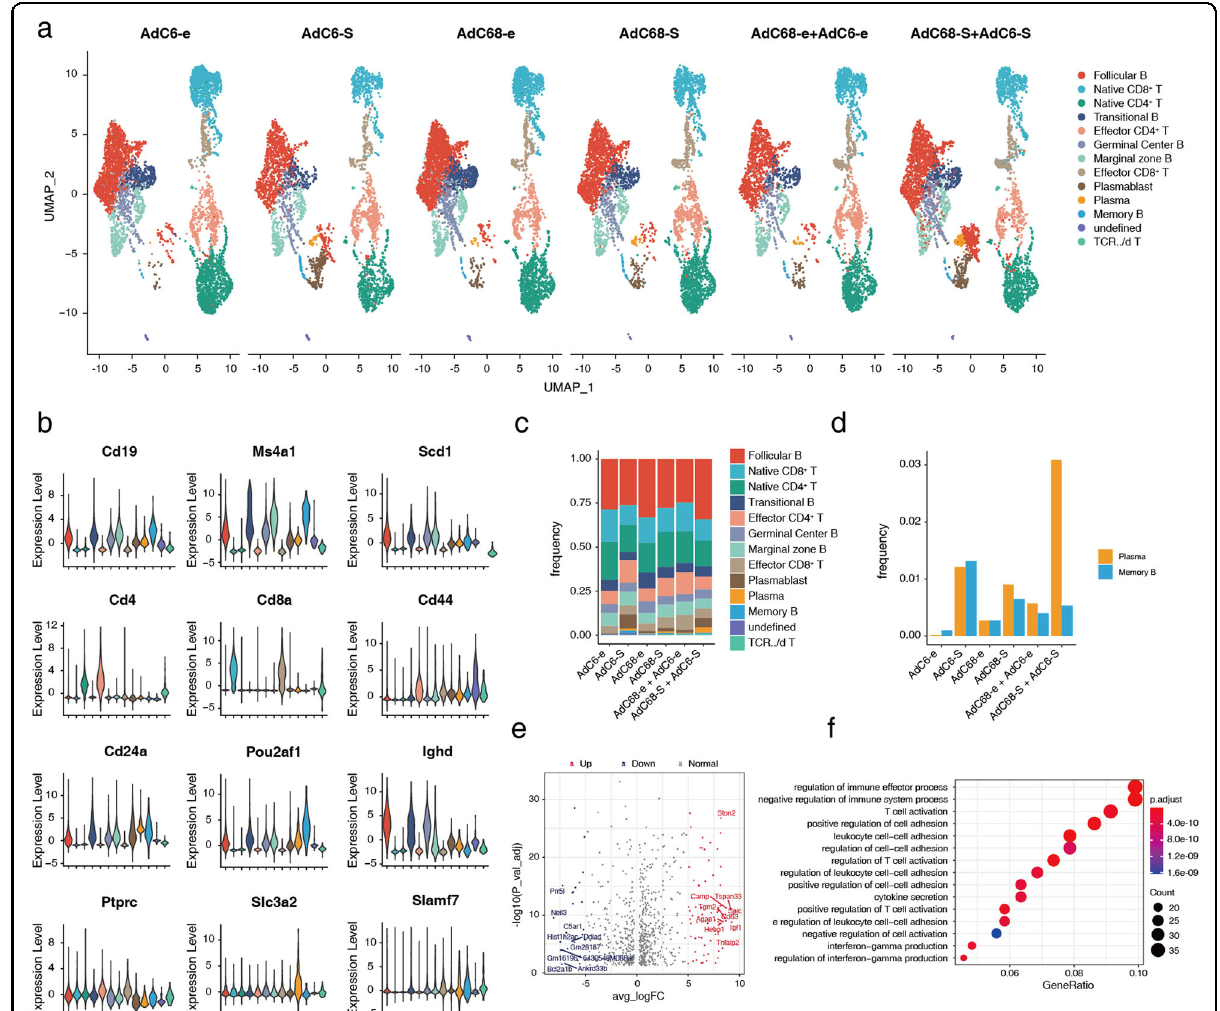
Fig. 4 Heterologous prime-boost vaccination generates more plasma cells with superior humoral immune responses in C57BL/6 mice. a UMAP dimensionality reduction embedding of T cells and B cells from vaccinated C57BL/6 mice. Cells are colored according to lineage subtypes. b Volcano plot displaying the expression levels of cell typing genes in subtype clusters. c Barplot of lineage subtype frequency in each group. d Bar graph summarizing the frequencies of plasma cells and memory B cells in each sample. e Volcano plot of DEGs in plasma cells and memory B cells of the group of mice vaccinated with AdC68-S and boosted with AdC6-S, compared to groups of mice immunized with AdC68-S and AdC6-S via single- dose route, respectively. Red dots represent genes signi fi cantly upregulated in prime-boost group (adjusted P < 0.05 and FC (fold change) ≥ 5), while blue dots represent signi fi cantly downregulated genes (adjusted P < 0.05 and FC ≤ 5). Top 10 genes are labeled by gene symbols. f Top 15 enriched GO terms for upregulated genes in prime-boost group compared to those in AdC68-S and AdC6-S single-dose groups in plasma cells and memory B cells. Dot color indicates the statistical signi fi cance of enrichment and dot size represents gene ratio annotated to each